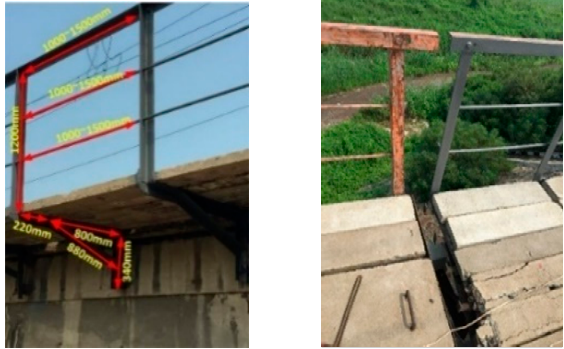
Figure 1. Steel guardrails and brackets in a railway bridge.